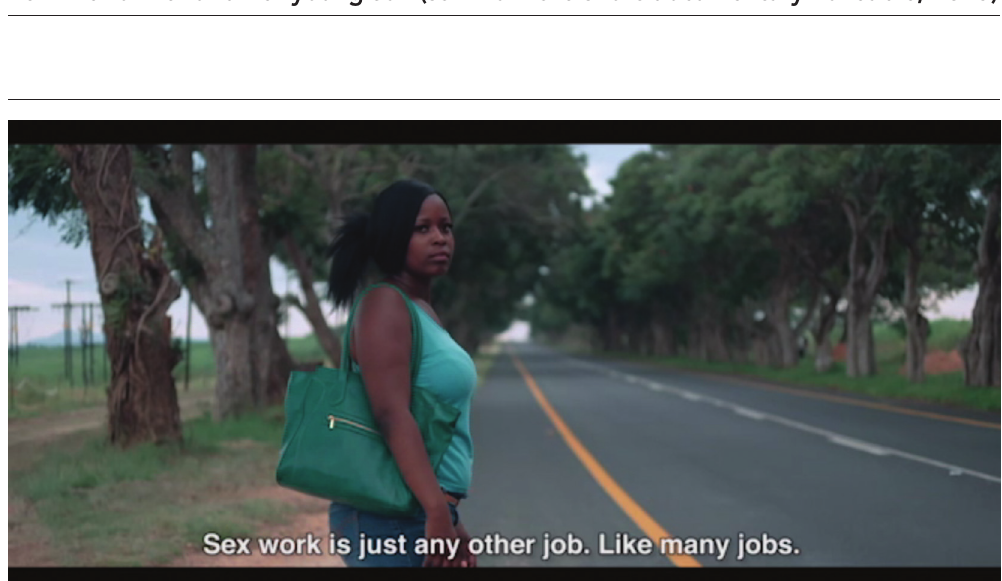
Figure 1: Thandeka Mokoena, a former sex worker from Klerksdorp, is seeking a new life for her and her young son (still from the short documentary Loveable , 2015)